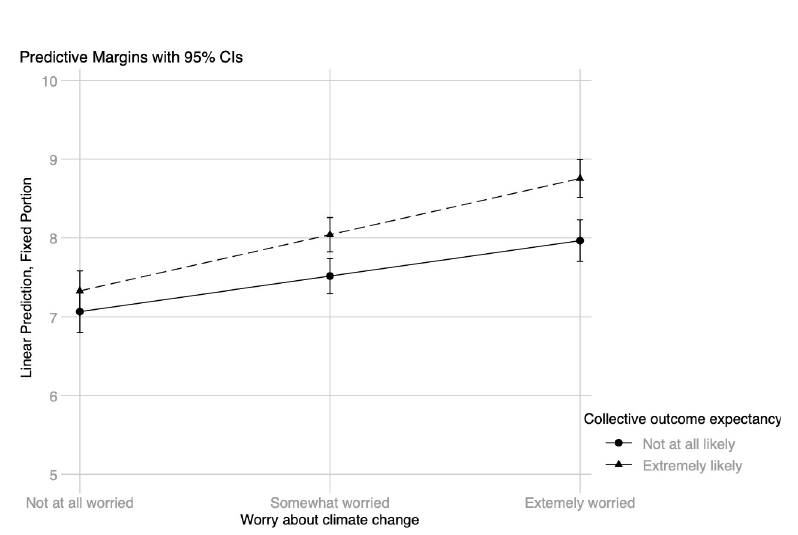
Fig 5. Energy efficiency behavior: Worry about climate change × collective outcome expectancy.